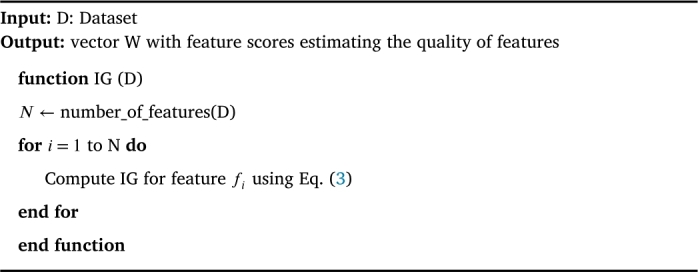
IG Algorithm [33].